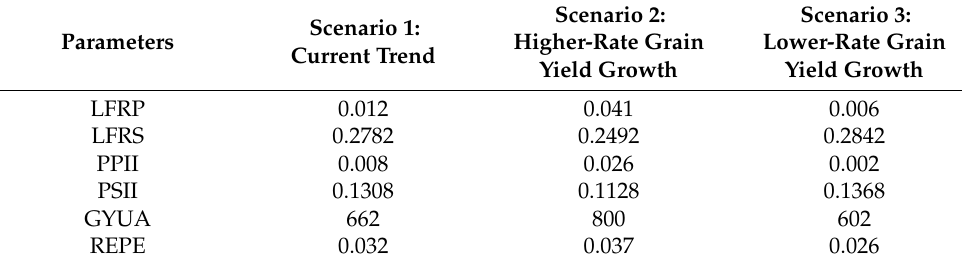
Table 1. Parameter setting of three scenarios to examine food role.